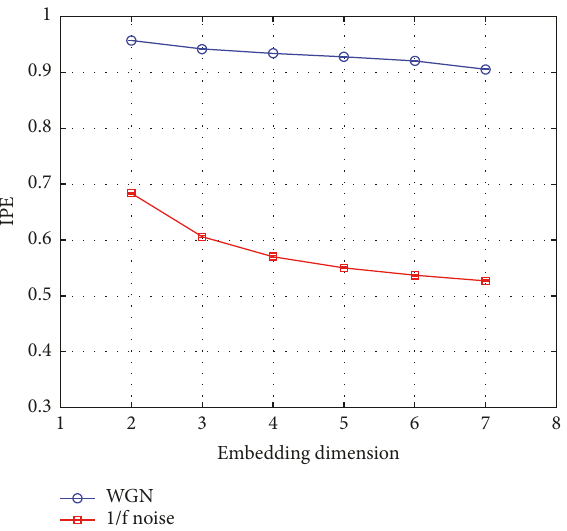
Figure 3: Error bar plot of IPE over a varying